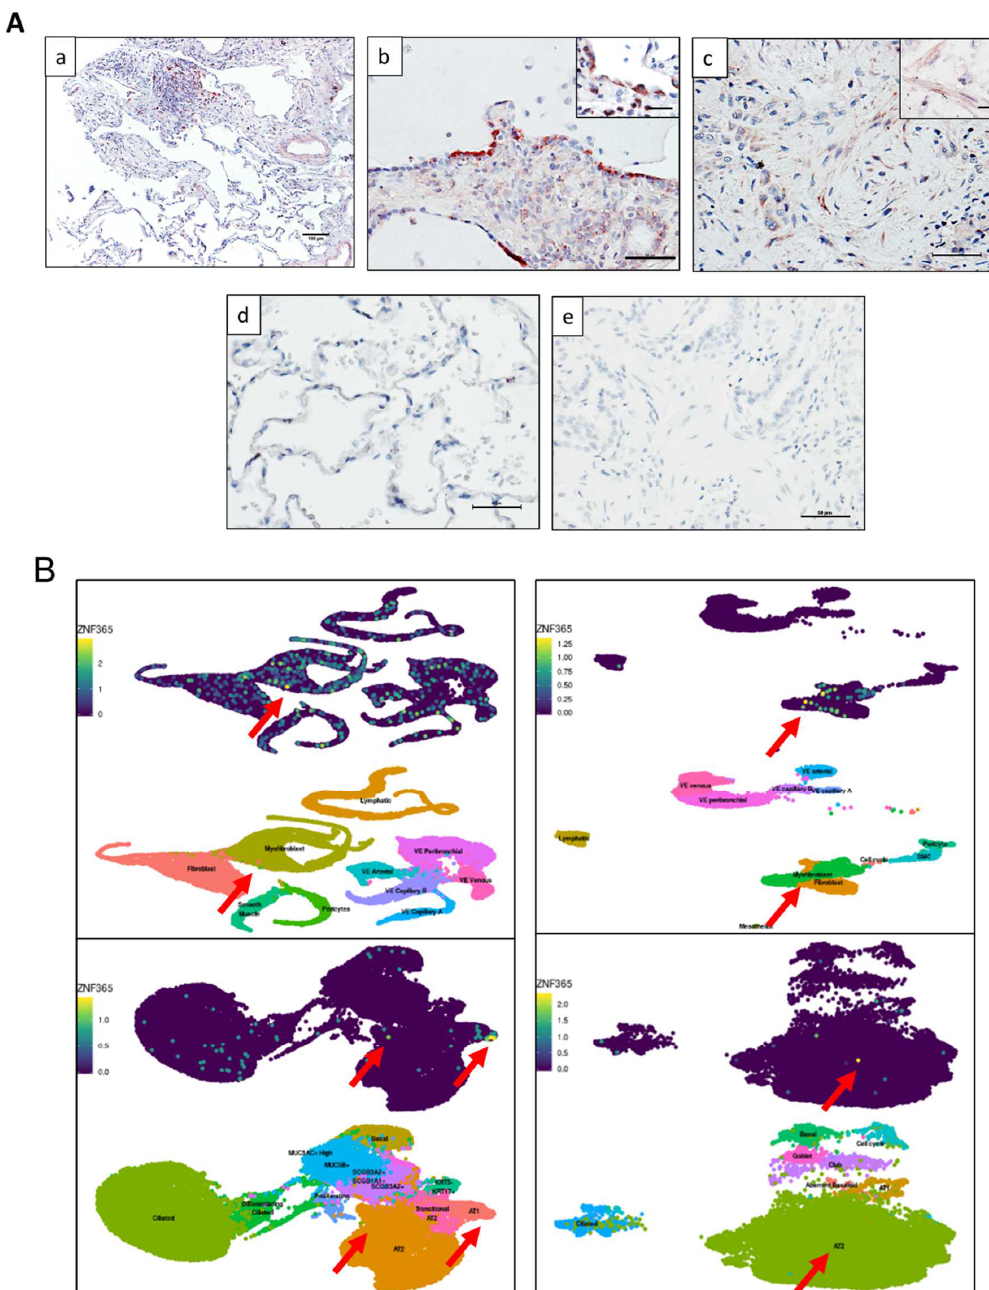
Figure 1. ZNF365 is expressed in IPF lung tissues. ( A ) ZNF365 is overexpressed in IPF lung tissues ( n = 5), and human control lungs ( n = 2) were stained for immunohistochemistry with the specific antibody. (a) Immunoreactive protein was located in fibroblast foci and alveolar epithelial cells (scale bar 100 μm). (b,c) Representative epithelial cells and fibroblasts in two different magnifications (scale bars 50 and inset 25 μm). (d) Immunostaining of lung tissue from control donor (scale bar 50 μm). (e) Immunostaining of IPF lung tissue without the primary antibody (scale bar 50 μm). ( B ) ZNF365 expression according to scRNAseq experiments from IPF Cell Atlas. (http://ipfcellatlas.com/, 9 August 2022).